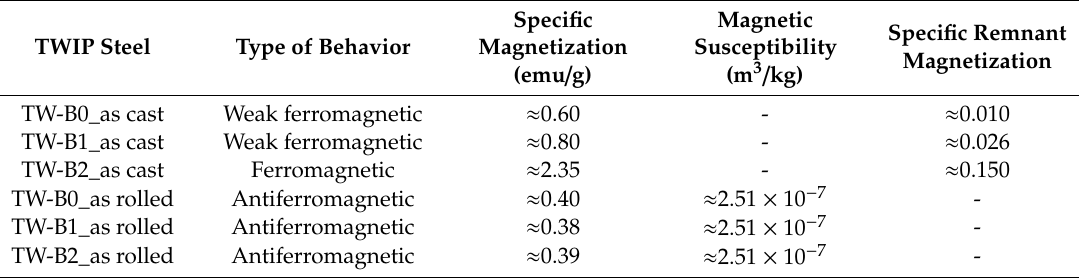
Table 3. Obtained magnetic properties in studied TWIP steels.